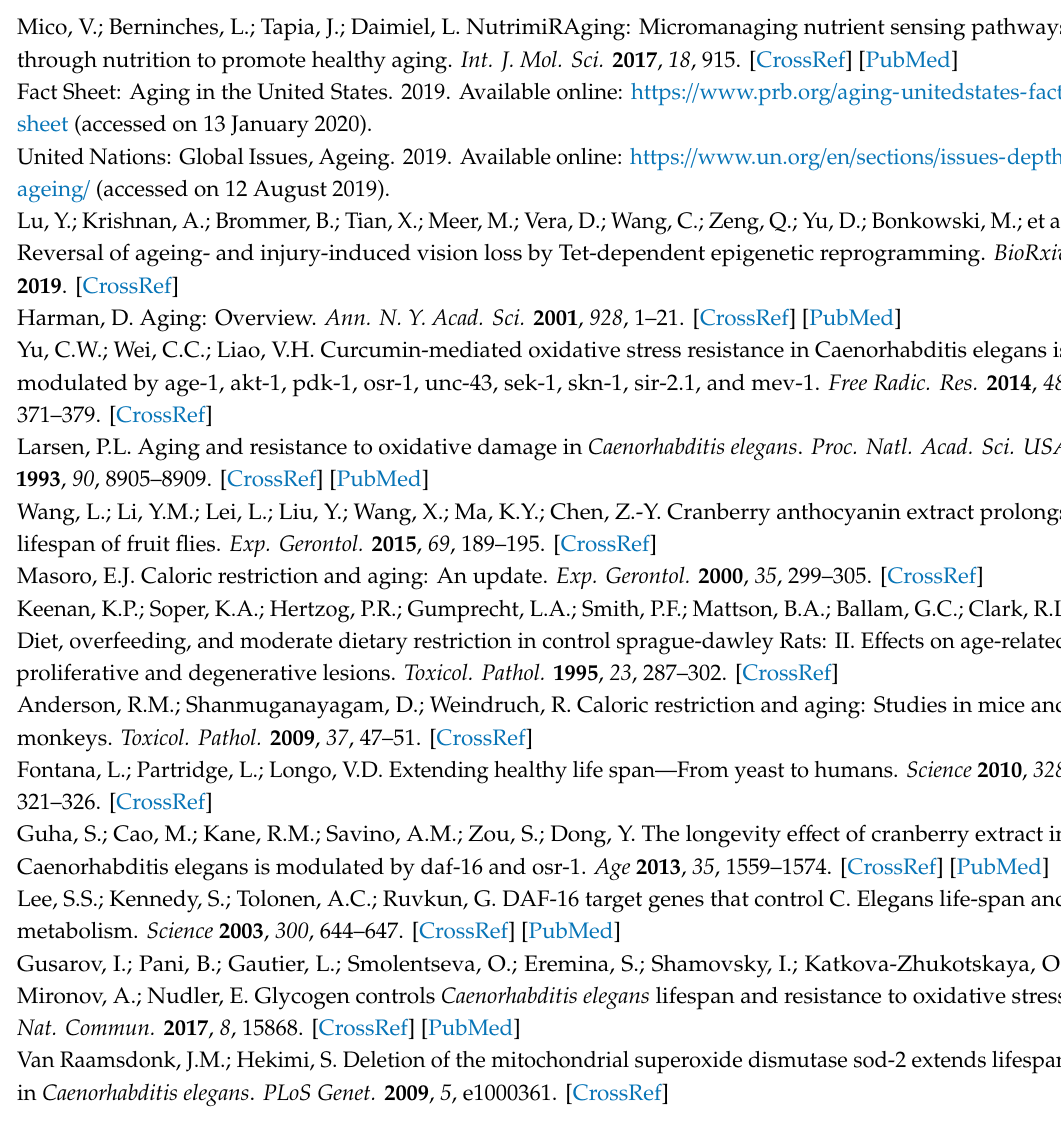
Table S1, the lifespan in wild type C. elegans with di ff erent concentrations of tart cherry at 20 ◦ C; Table S2, the lifespan in daf-16 mutant C. elegans with di ff erent concentrations of tart cherry at 20 ◦ C; Table S3, the